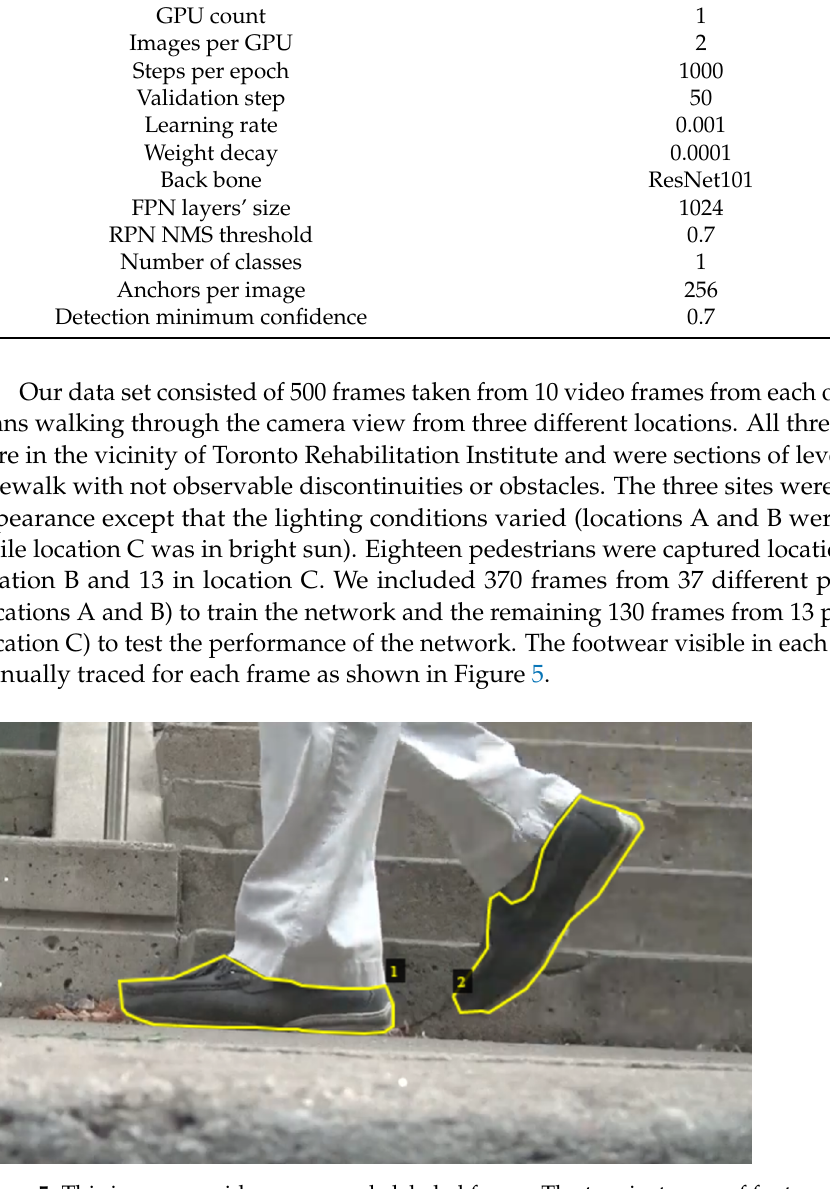
Figure 5. This image provides an example labeled frame. The two instances of footwear are traced with a yellow line. The masks are then given to the network as the ground